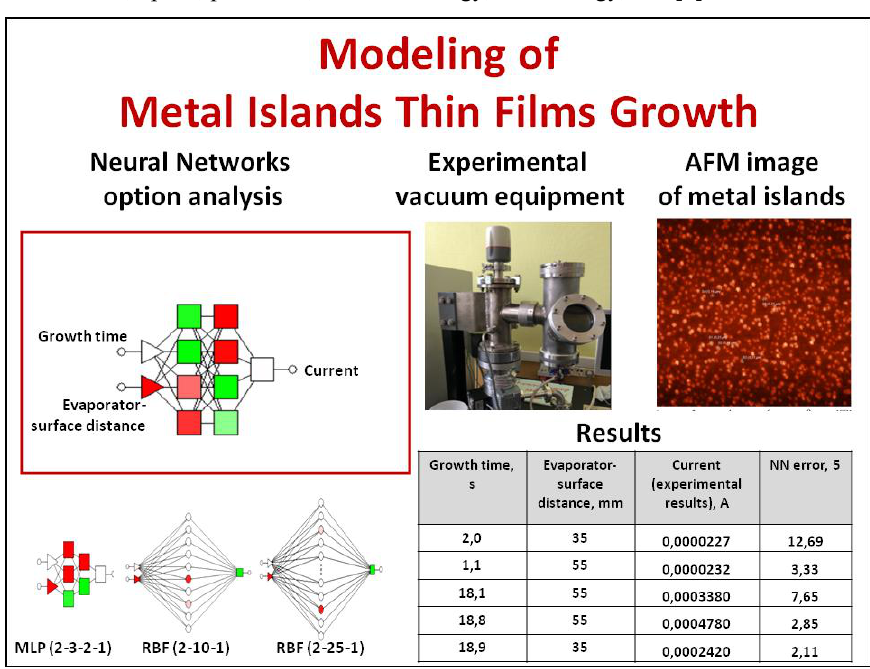
Fig. 4. An example of the presentation of the results of neural network modeling of metal islands growth in the graduation